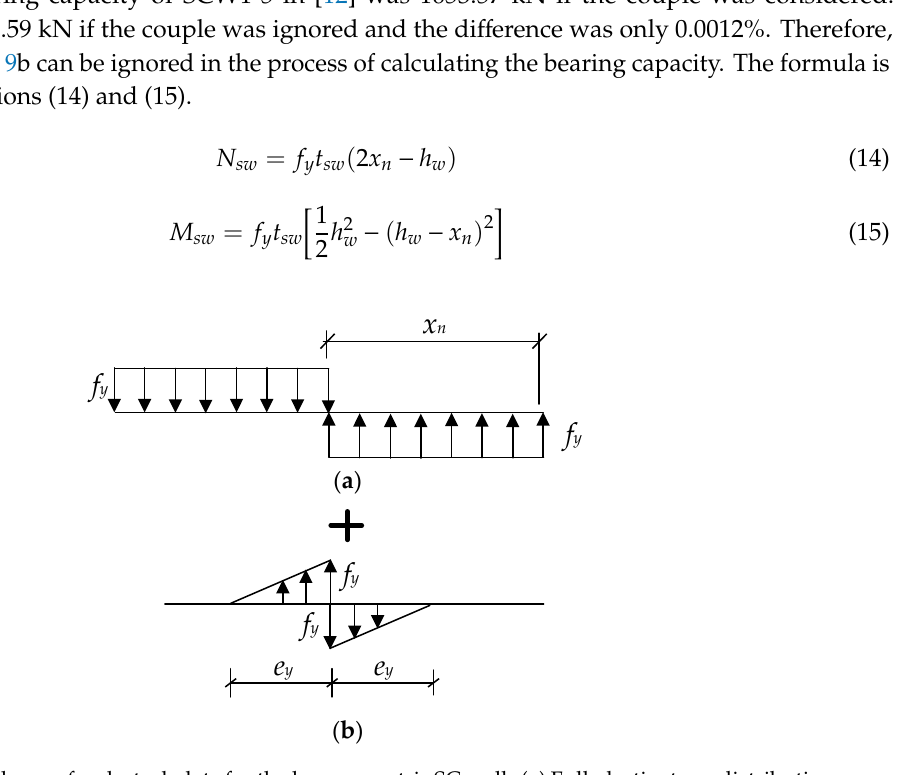
Figure 9. Equivalence of web steel plate for the large eccentric SC wall. ( a ) Full plastic stress distribution; ( b )Triangle stress distribution.